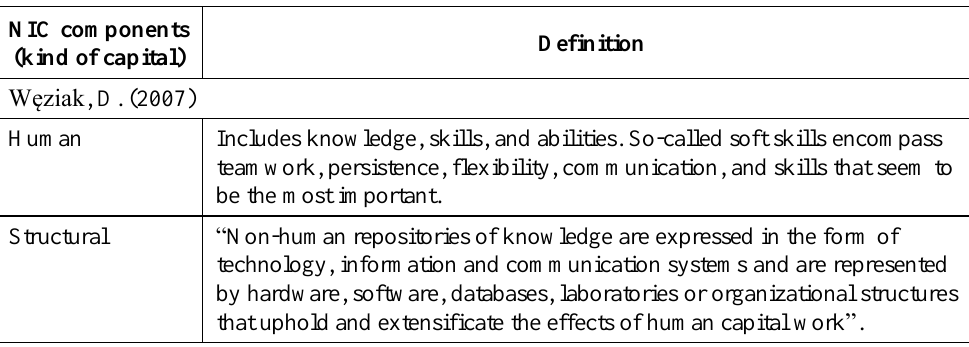
Table 1. NIC components and